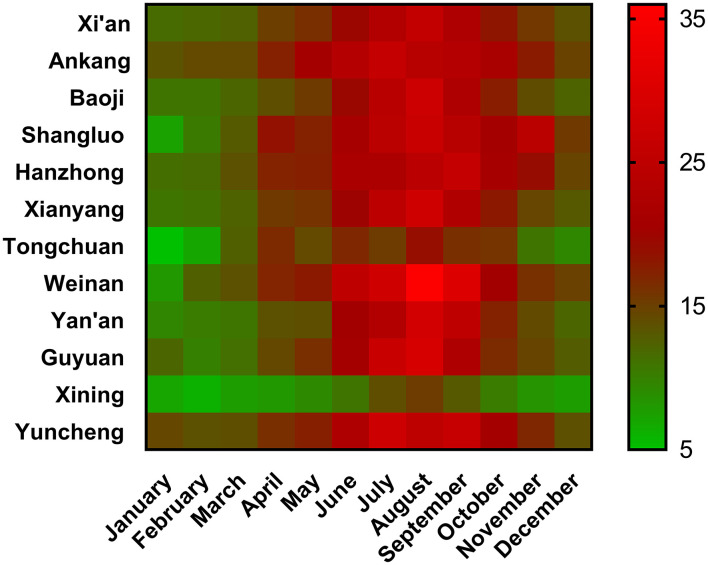
Vitamin D levels in the different cities and months. Median value was shown in each cell.